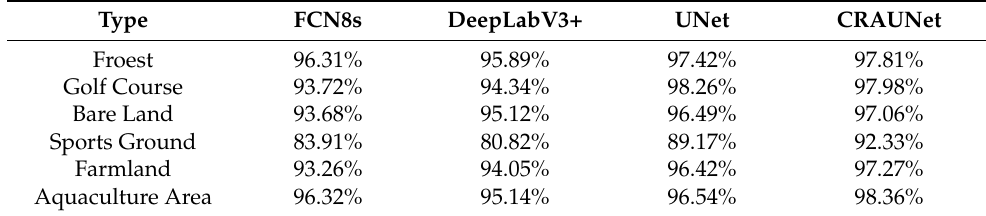
Figure 11. Typical Urban green space classification results. ( a ) The original images; ( b ) corresponding labels; ( c ) the predicted maps of FCN8s, ( d ) the predicted maps of DeepLabV3+; ( e ) the predicted maps of UNet; ( f ) the predicted maps of CRAUNet. Table 5. The accuracy of different